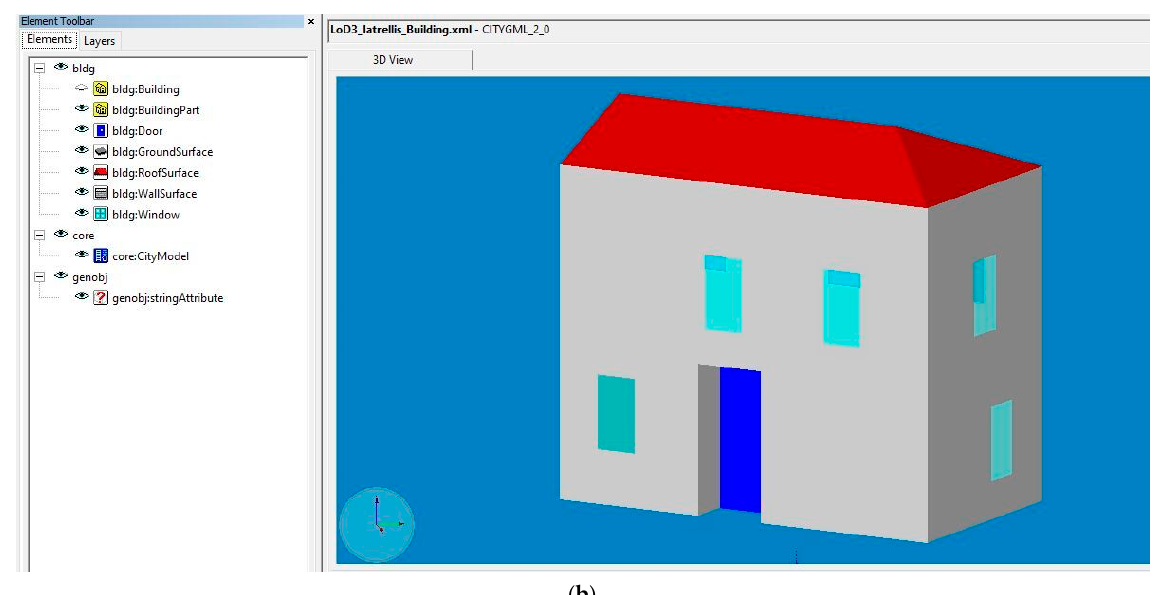
Figure 10. LOD3 CityGML building models with semantic layers rendered in FZK viewer for ( a ) building A and ( b ) building B.